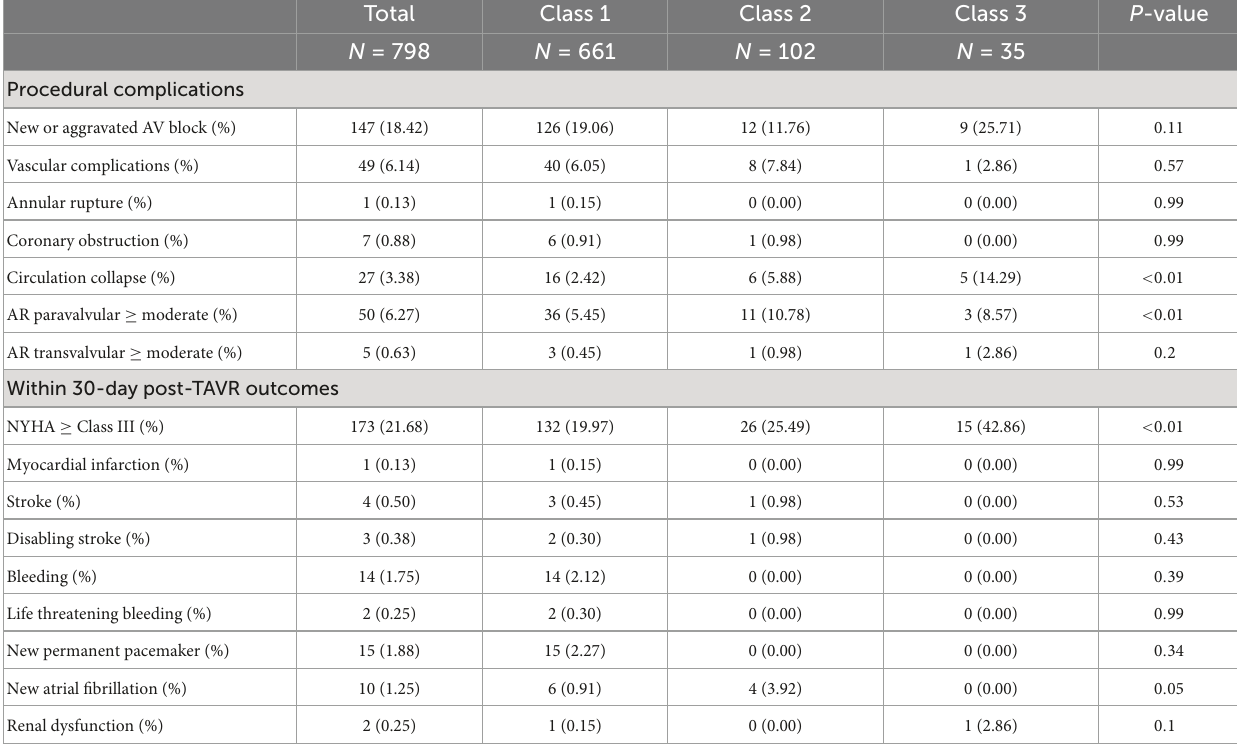
TABLE 2 Procedural complications and 30-day clinical outcomes after